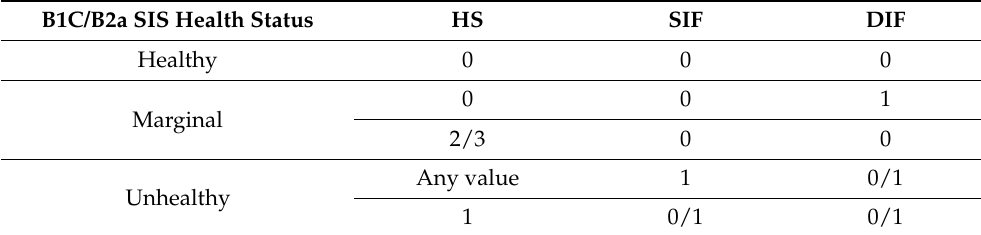
Table 3. B1C/B2a SIS health status